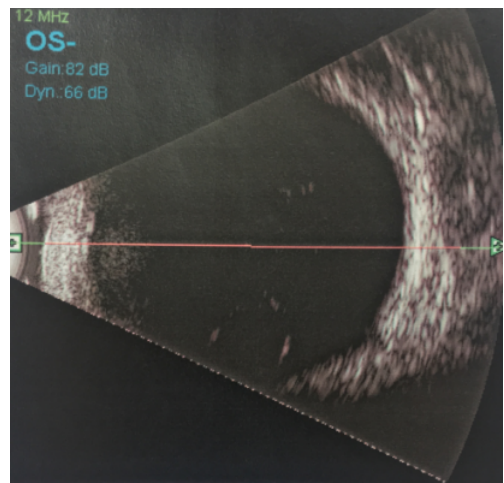
Figure 4: B-scan ultrasound of the left eye with vitreous